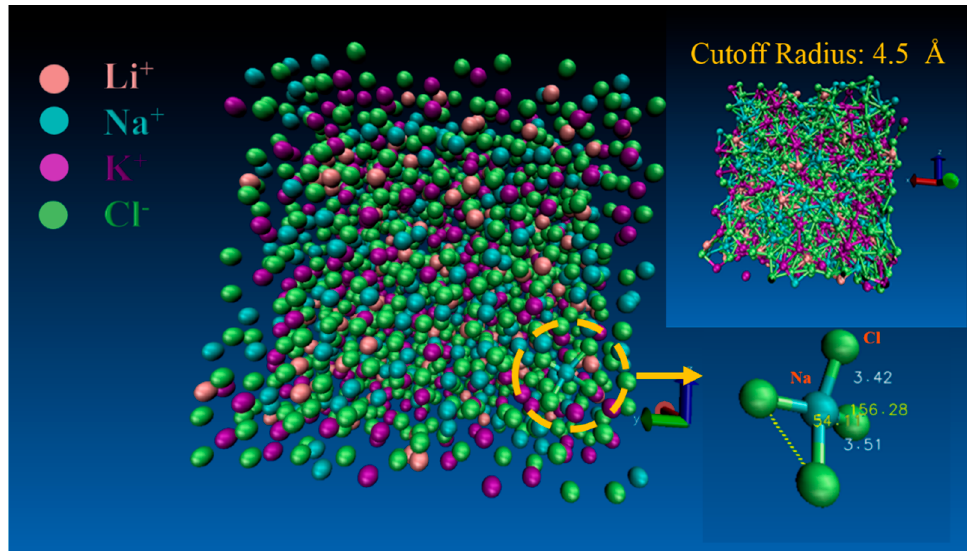
Figure 4. Snapshot of A-2 at 1100 K from molecular dynamics (MD) simulation.